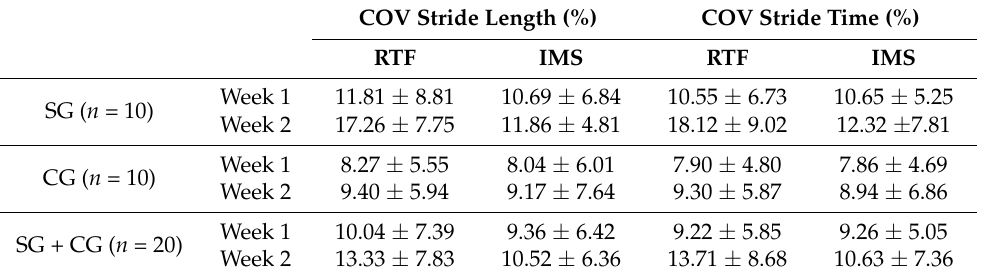
Table 3. Coefficient of variation (COV) of stride length and COV of stride time of SG, CG, and in total (SG + CG) for week 1 and week 2. Values are means ± standard deviations.